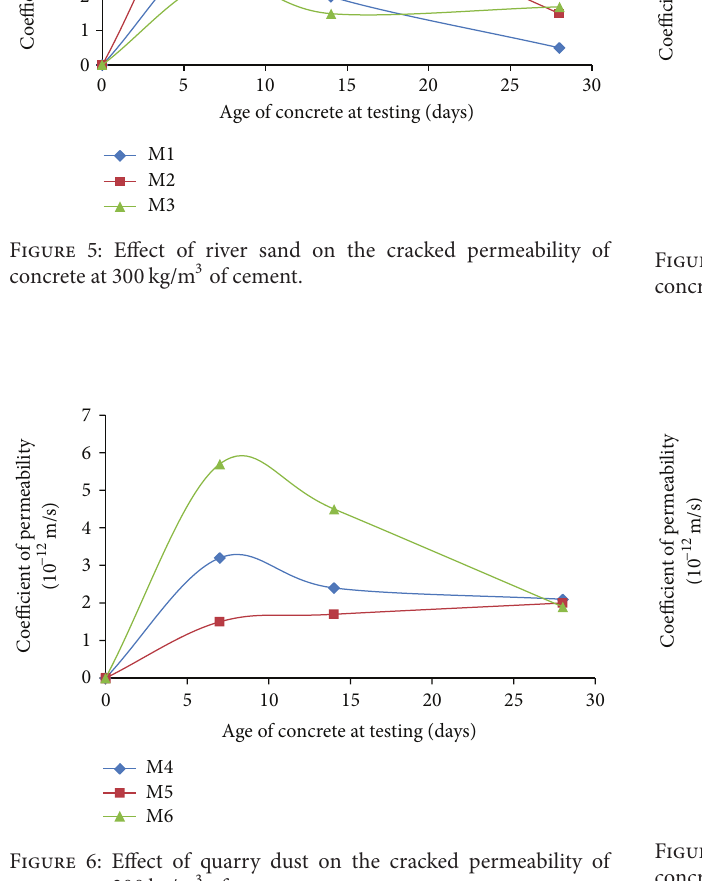
Figure 6: Effect of quarry dust on the cracked permeability of concrete at 300 kg/m 3 of cement.